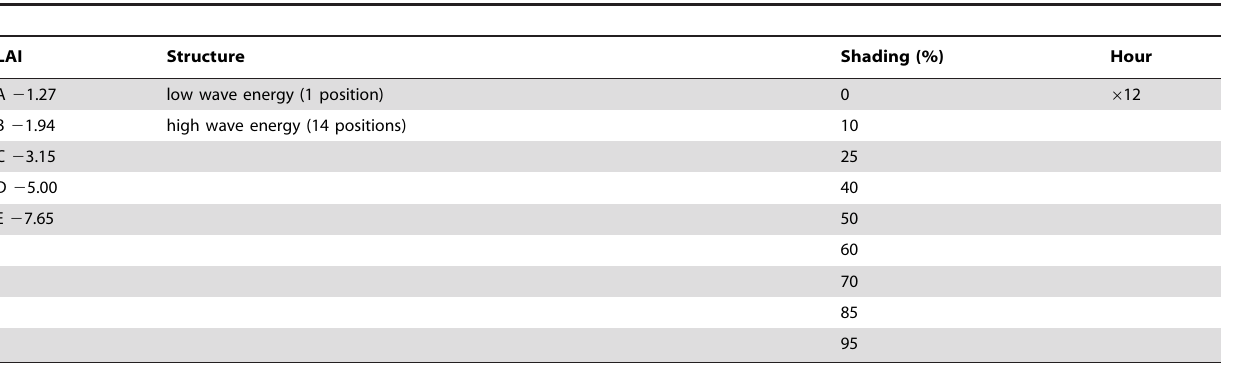
Table 1. Modelling experiment